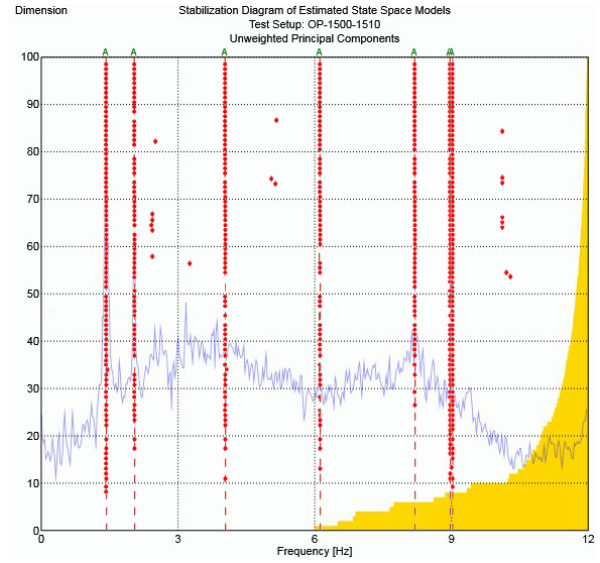
Figure 7. Stabilization diagram of the wind turbine under opera- tional conditions (OP), with a rotor speed of 41rpm.